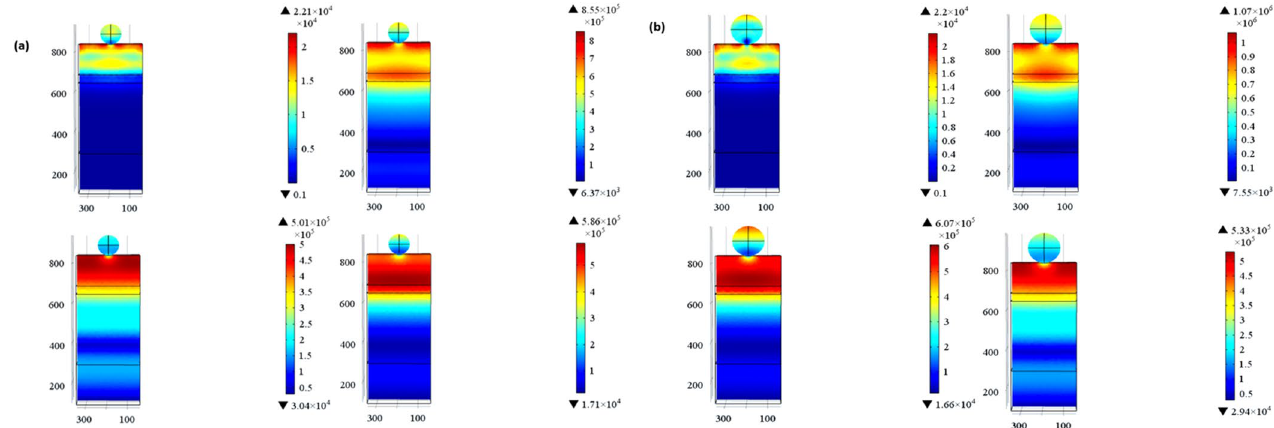
Figure 6. Electric field profiles of the ZrN-decorated PSCs: ZrN radii ( a ) 50 nm ( b ) 75 nm, and ( c ) 100 nm at wavelengths of 300 nm, 800 nm, 1000 nm, and 1200 nm, respectively.